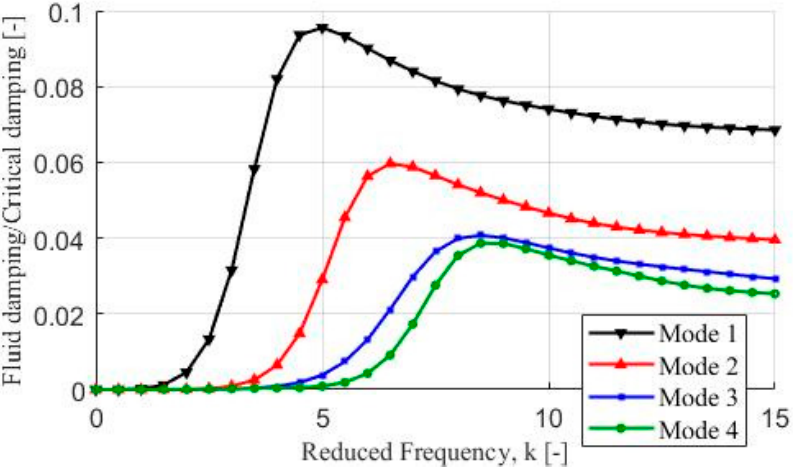
Figure 9. Fluid damping ratio as function of reduced frequency for rectangular simply supported plate.